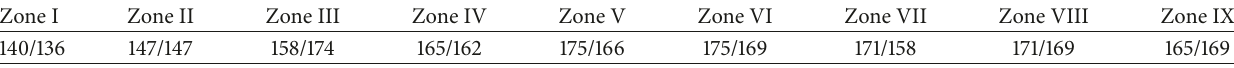
Table 2: Preset/achieved temperature [ ∘ C] for the compounding of recycled polypropylene with thermoplastic elastomers. Zone I